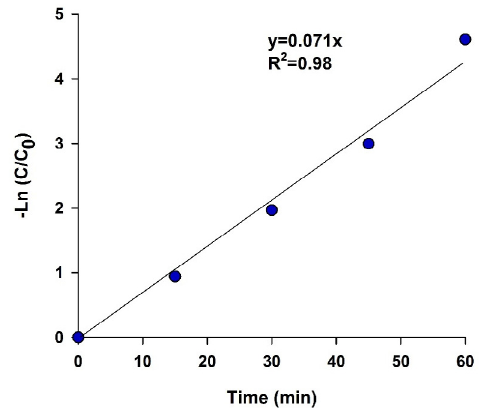
Fig. 11. Kinetic of PHP degradation at optimum operating con- ditions: pH = 7, 0.1 A, [PHP] =10 ppm, and [catalyst] = 0.2 g L -1 .